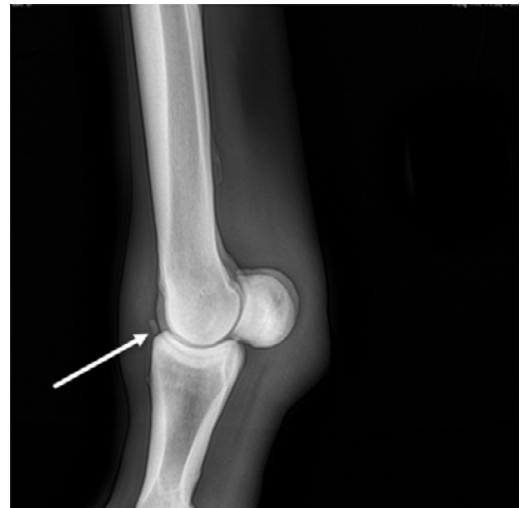
Figure 6: Lateromedial projection of the fetlock of a 13-year-old Arab gelding with an articular fragment on the dorsoproximal aspect of the proximal phalanx. This gelding was affected